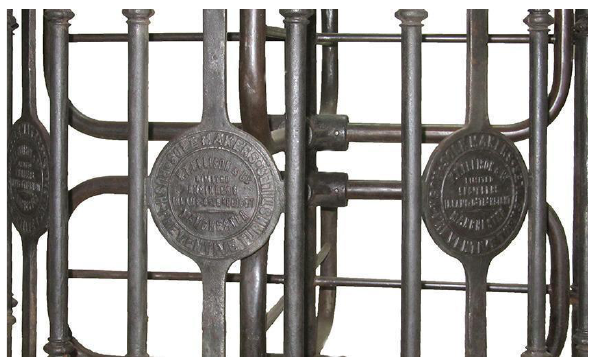
Figure 12. Turnstile blades of the Cordillera elevator. Source: Xiloscopio